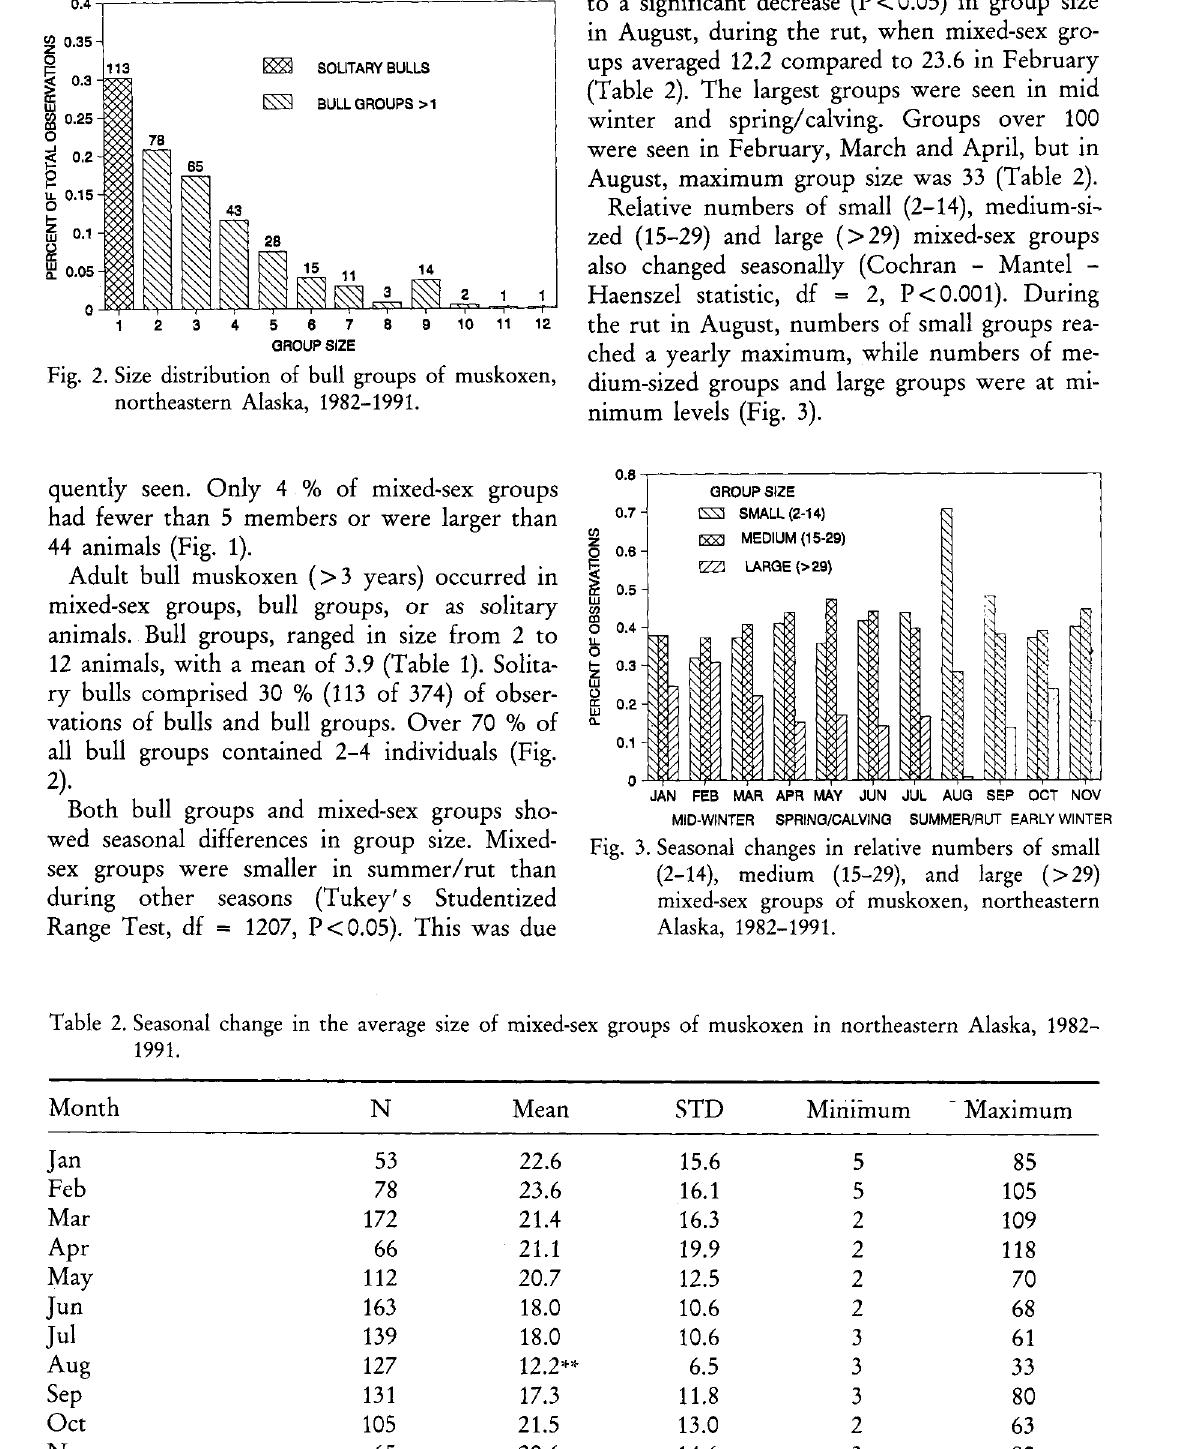
Table 2. Seasonal change in the average size of mixed-sex groups of muskoxen in northeastern Alaska, 1982¬